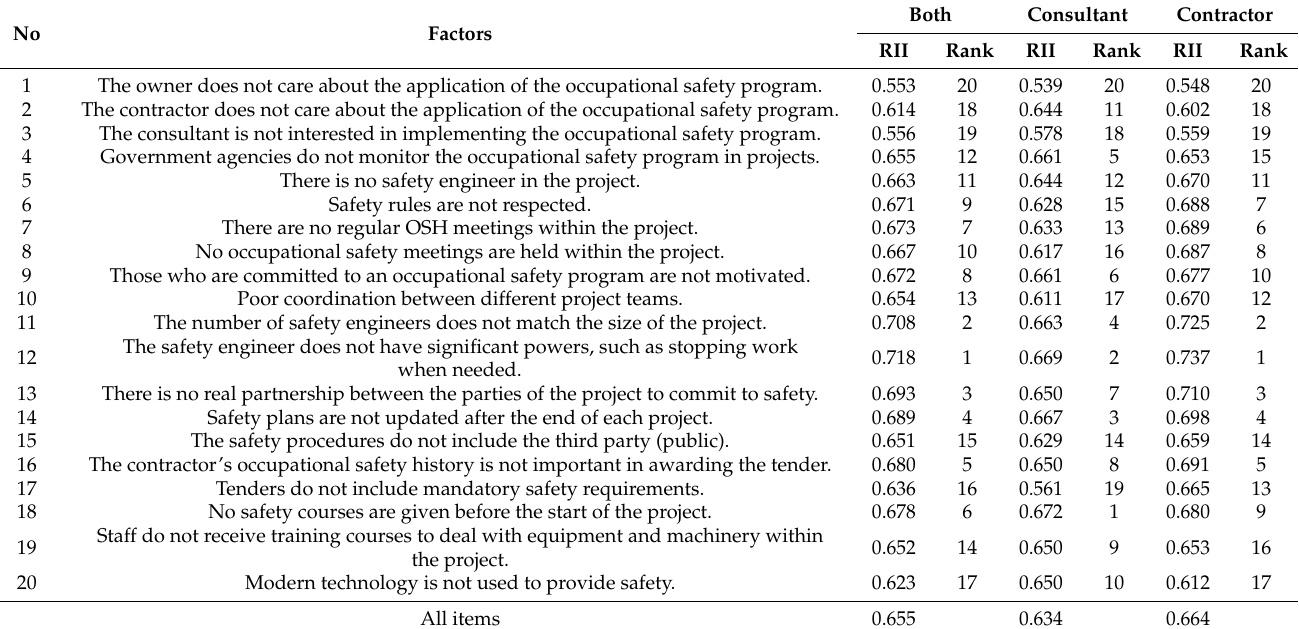
Table 6. Rank and RII of items related to management